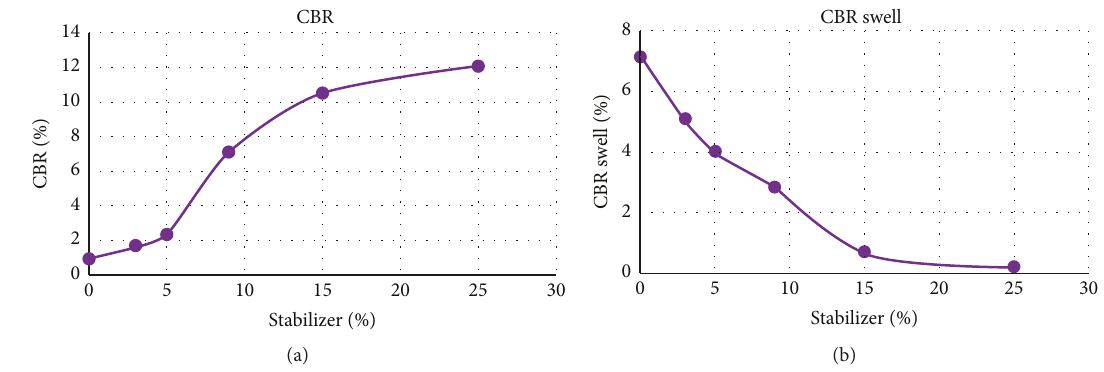
Figure 7: The effect of stabilizer on CBR and CBR swell.